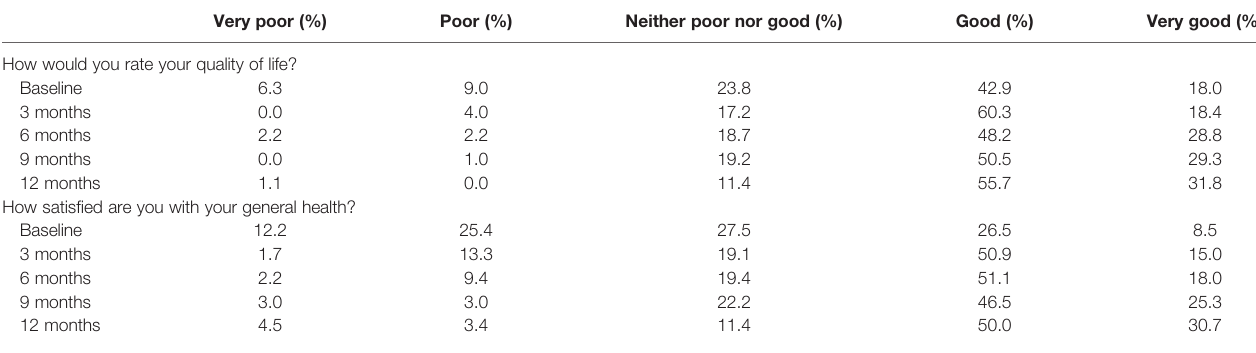
TABLE 2 | Overall quality of life and general health.